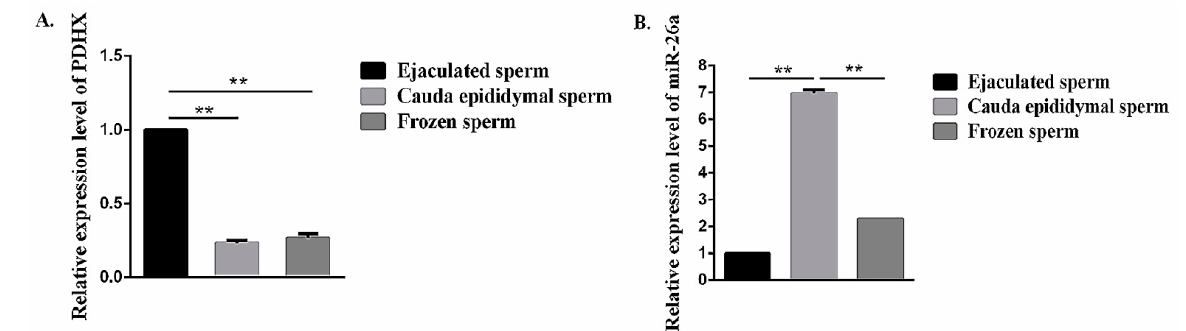
Figure 4. The expression level of miR-26a and PDHX in the epididymal cauda, ejaculated sperm and frozen-thawed sperm. ( A ) PDHX . ( B ) miR-26a. “**” indicates statistical significance at P < 0.01.